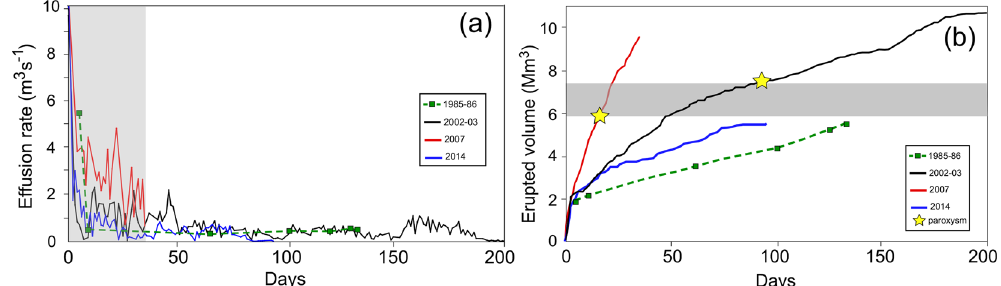
Figure 3. ( a ) Comparison between the effusion rate trends relative to the 1985 (dashed green), 2003 (black), 2007 (red) and 2014 (blue) eruptions. The shaded gray area represents the exponentially decreasing trend of the first 35 days. ( b ) Cumulative volumes for the same eruptions. The gray line represents the threshold of 6.5 ± 1 × 10 6 m 3 of erupted lava, after which the paroxysmal explosions (yellow stars) occurred in 2003 and 2007, at 15 and 90 days from the eruption onset,